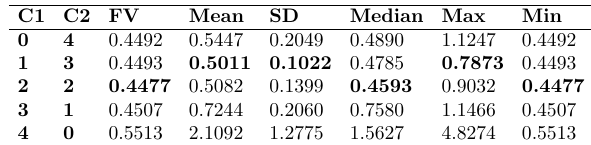
Table 3. Effect of acceleration